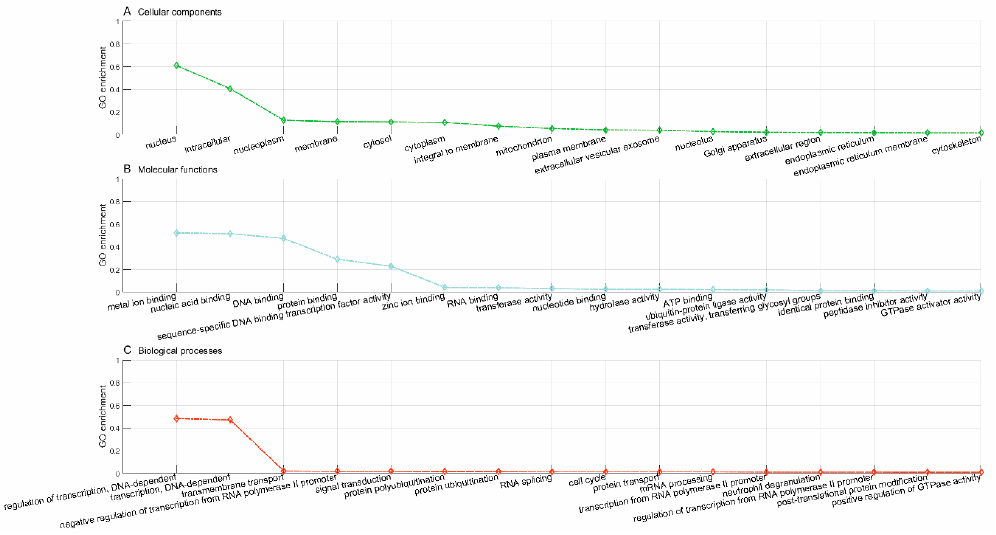
Figure 5. GO enrichment analysis of the predicted novel genes targeted by drug CIDm00004156.